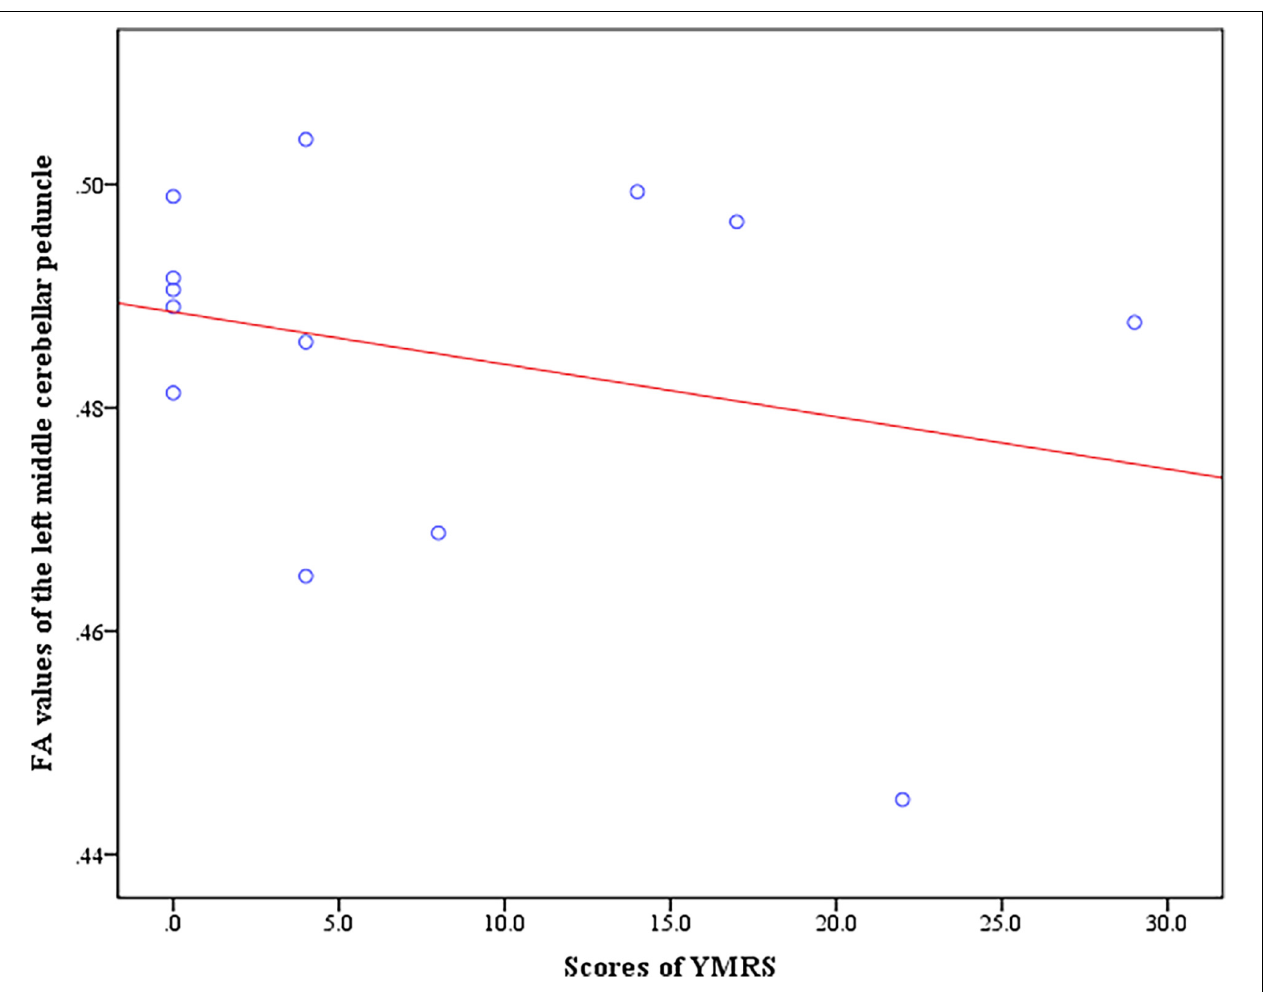
FIGURE 4 | Negative correlation between the scores of YMRS and FA values of the left middle cerebellar peduncle in BD + S